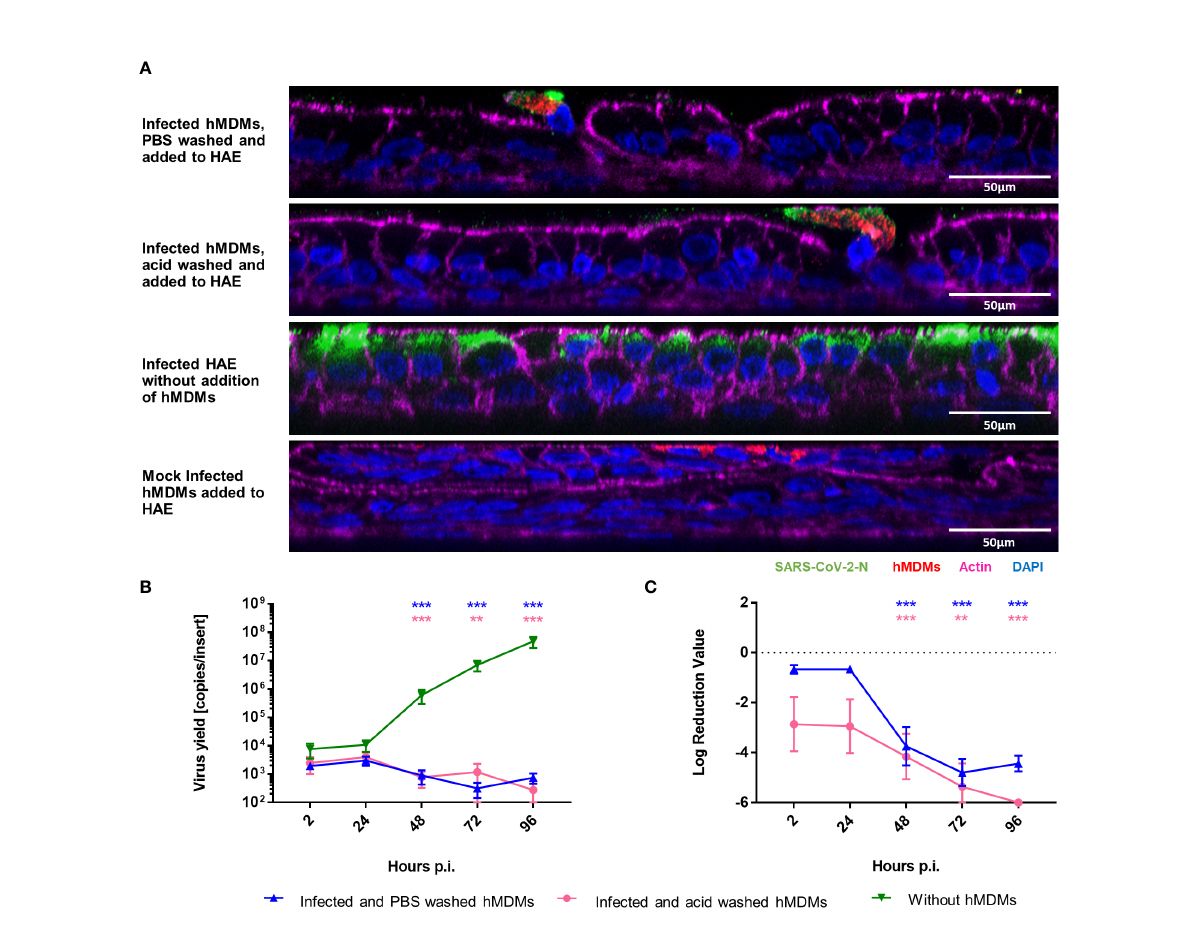
FIGURE 2 hMDMs do not transfer the infectious virus to other cells or tissues. SARS-CoV-2 Infected hMDMs were added to HAE to analyse the virus transmission from hMDMs to other cells. (A) Confocal microscopy images of HAE co-cultured with infected hMDMs were taken. Mock control and infected HAE without hMDMs are also shown. Images were obtained at 72 h p.i. SARS-CoV-2 N protein is shown in green; CD68, hMDMs marker, is shown in red, actin is shown in magenta and nuclei in blue. (B, C) graphs shows the quanti fi cation of viral replication in hMDMs co- cultures, evaluated by RT-qPCR. Data are presented as the number of RNA copies per ml (B) and the relative log reduction in the virus yield (C) . Data were obtained from three independent experiments, each experiment was carried out in triplicate and means ± SEM is shown. Groups were compared by the Kruskal-Wallis test and Dunn ’ s multiple comparisons test. **p<0.01,